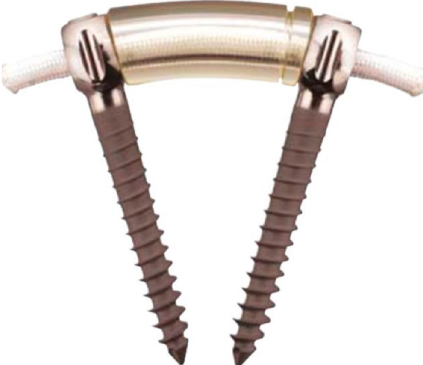
Figure 1: The dynesys system consists of titanium alloy screws, polyethylene terephthalate cords, and hollow cylinder poly- carbonate urethane